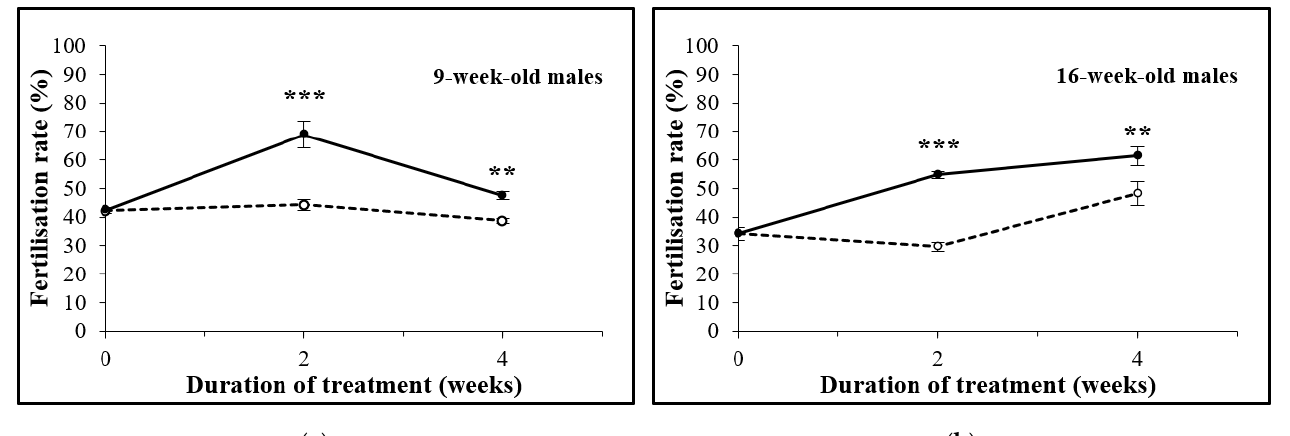
Figure 2. The in vitro fertilization rate with spermatozoa obtained from 9-week-old ( a ) and 16-week-old males ( b ) treated (continuous lines) or not treated (dotted lines) with D-Asp. Significant differences between D-Asp-treated males and controls are marked as follows: **: p < 0.01, ***: p < 0.001.